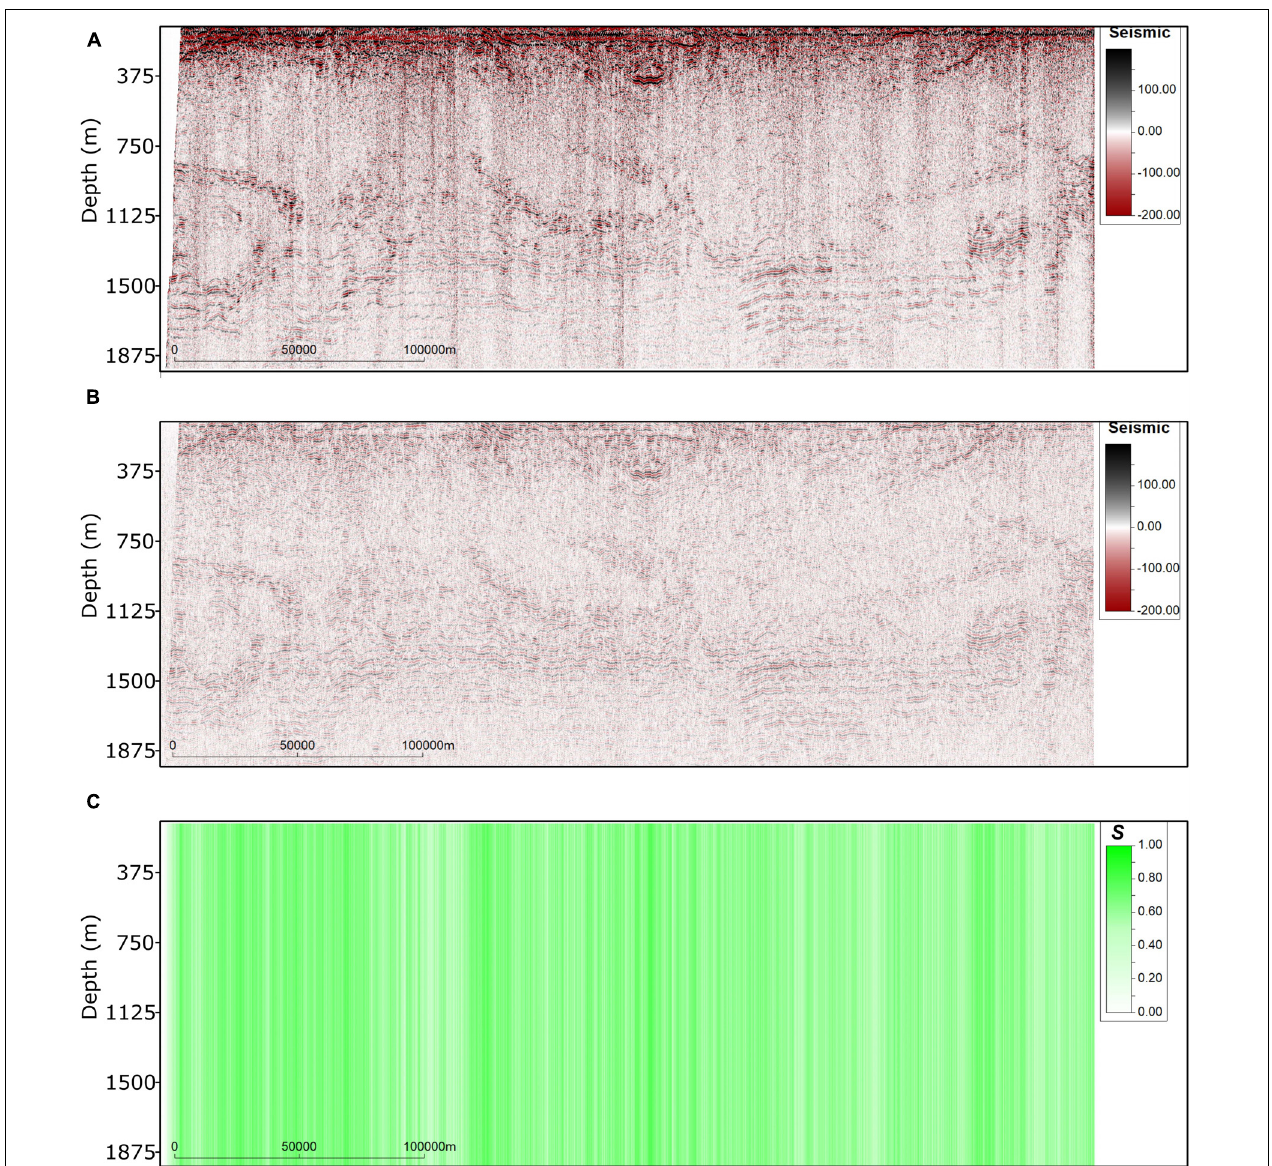
FIGURE 11 | (A) Observed SO data used in the inversion; (B) synthetic SO data computed from the pointwise mean temperature and salinity models generated during the last iteration; (C) trace-by-trace S between (A,B)